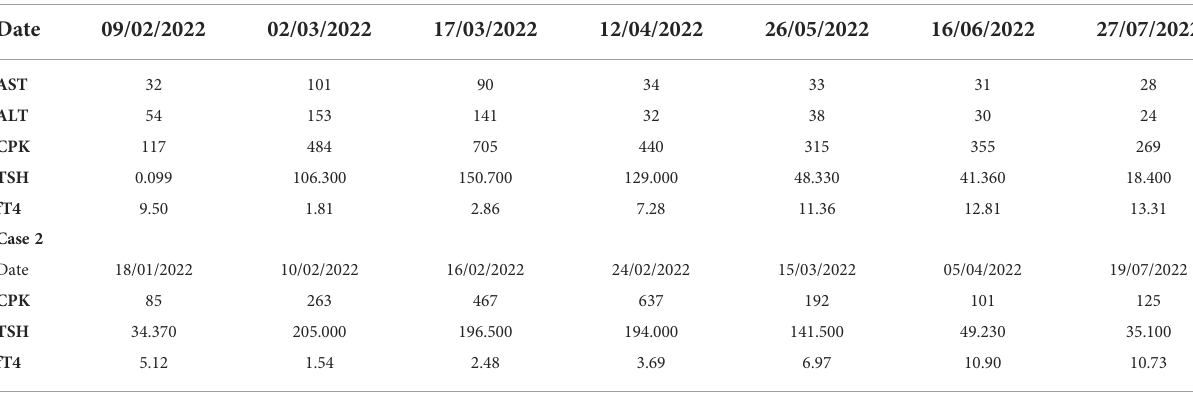
TABLE 1 Thyroid hormones, transaminases, and creatine phosphokinase levels over